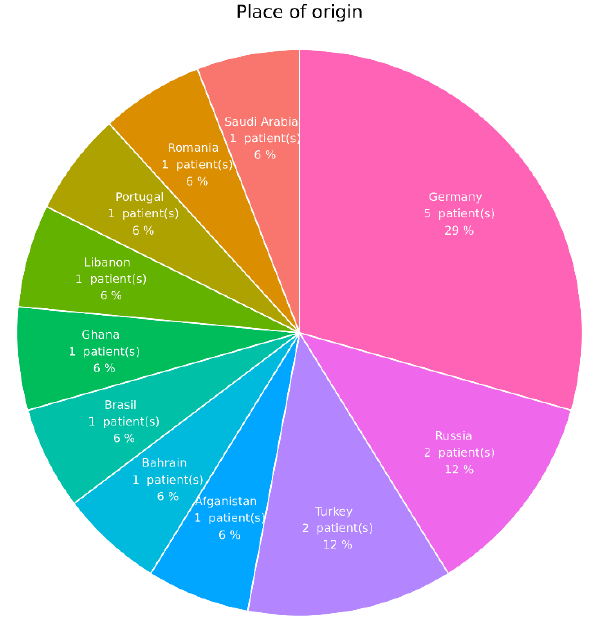
Figure 1. Shows the distribution of countries where the patients originated: Germany, 29.4% ( n = 5); Russia, 11.8% ( n = 2); Turkey, 11.8% ( n = 2); Afghanistan, 5.88% ( n = 1); Bahrain, 5.88% ( n = 1); Brazil, 5.88% ( n = 1); Ghana, 5.88% ( n = 1); Lebanon, 5.88% ( n = 1); Portugal, 5.88% ( n = 1); Romania, 5.88% ( n = 1); Saudi Arabia, 5.88% ( n = 1).